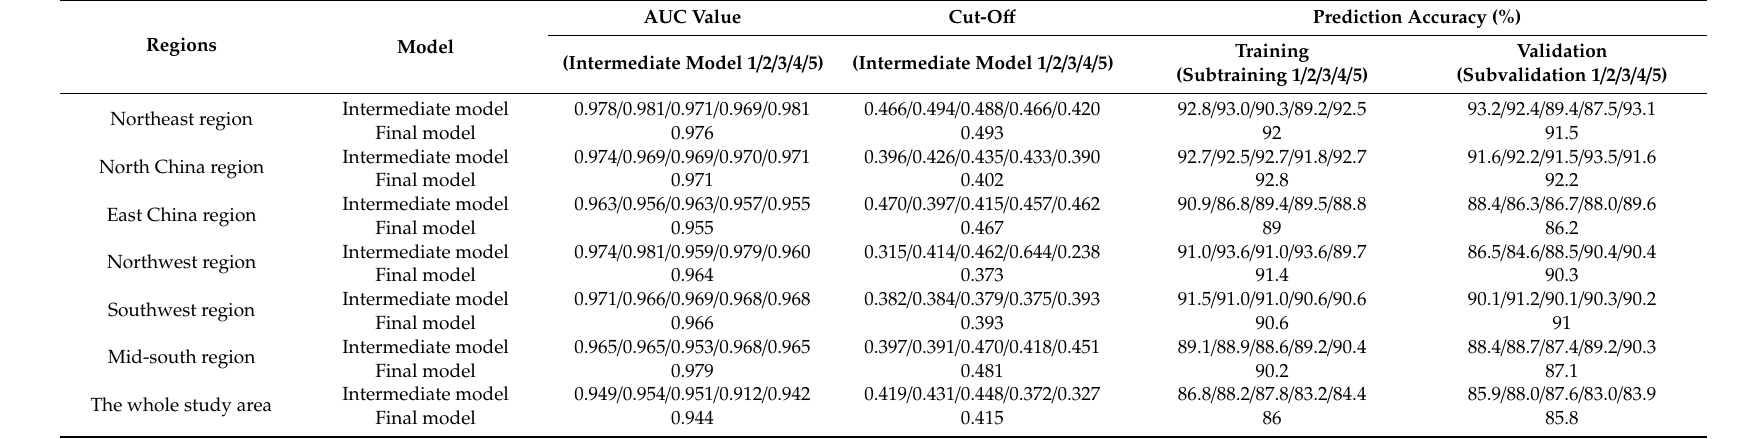
Table 5. Comparisons of prediction accuracy of random forest